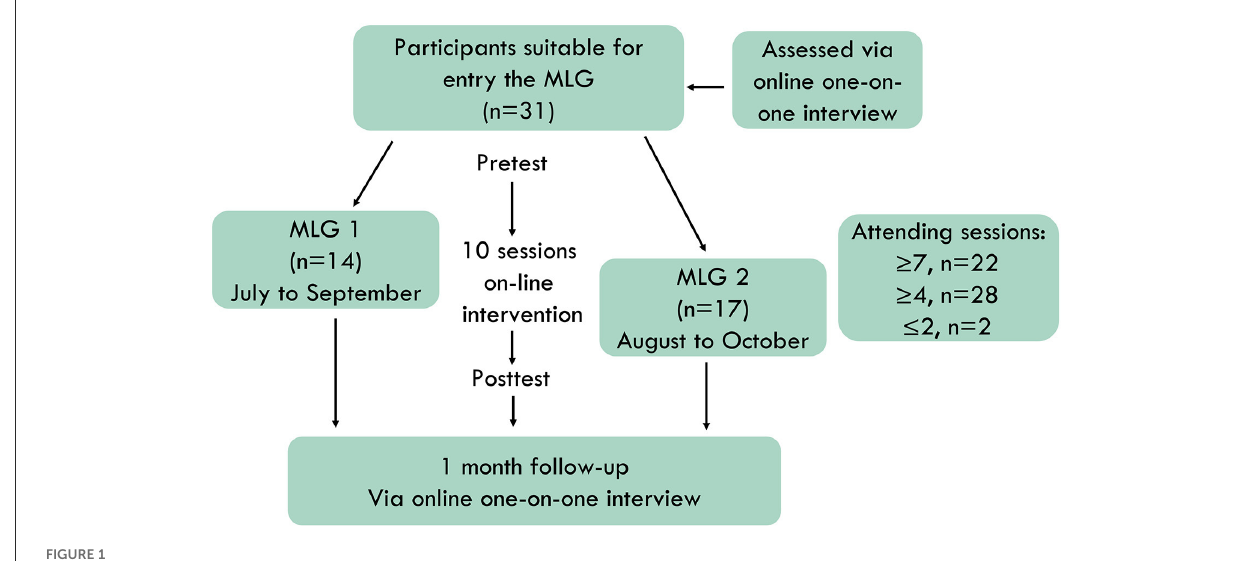
FIGURE1 Flow of participants throughout the study.